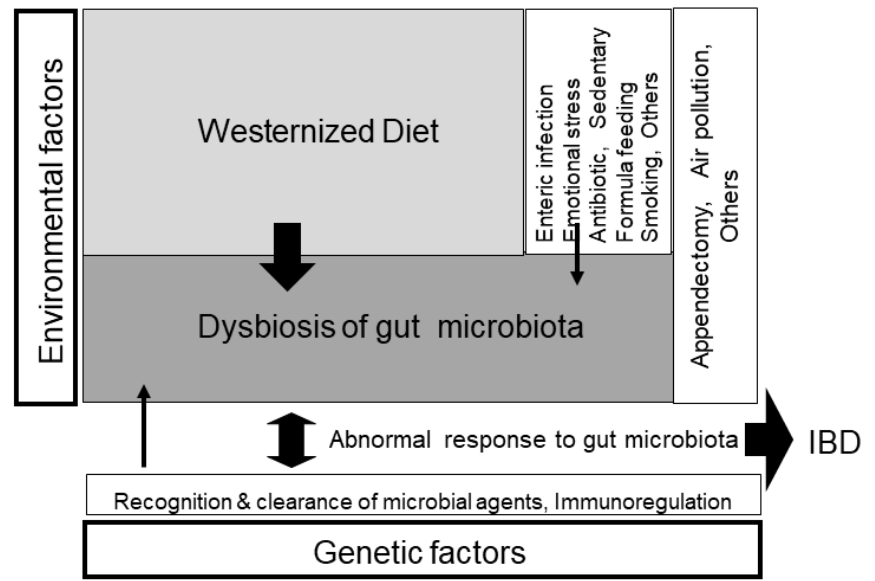
Figure 7. Schematic pathogenesis of inflammatory bowel disease (IBD). IBD occurs in genetically susceptible persons when triggered by environmental factors. The breadth of the arrow reflects the degree of the contributing role in the pathogenesis. The greatest environmental factor is gut dysbiosis (imbalance of gut microbiota), which is formed by a westernized diet, namely, westernized diet-associated gut dysbiosis [4] (with permission from the Permanente